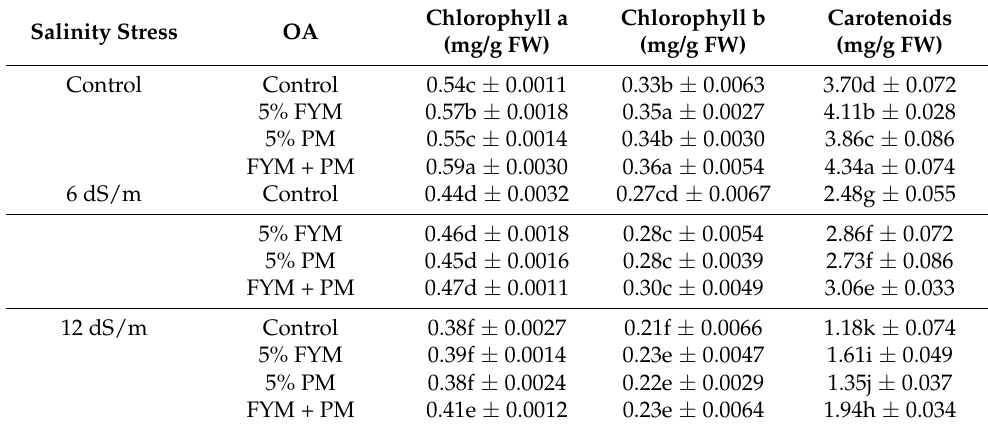
Table 2. Effect of different organic amendments on photosynthetic pigments under diverse salt stress levels.